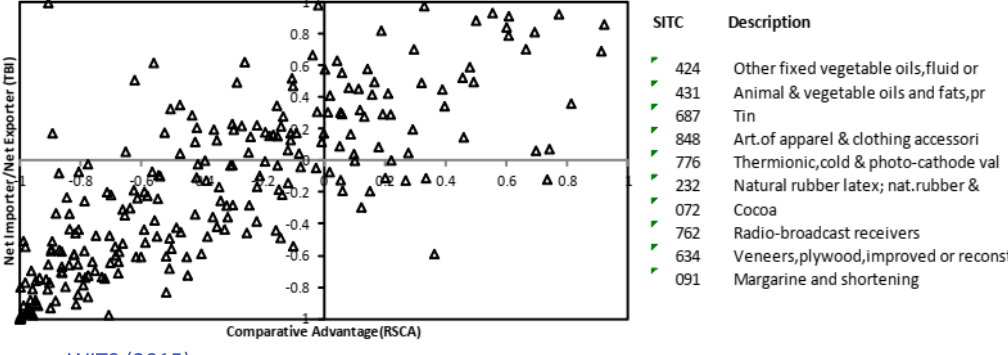
Figure 11: Products Mapping and the Top-Ten Export Products of Malaysia, 2014